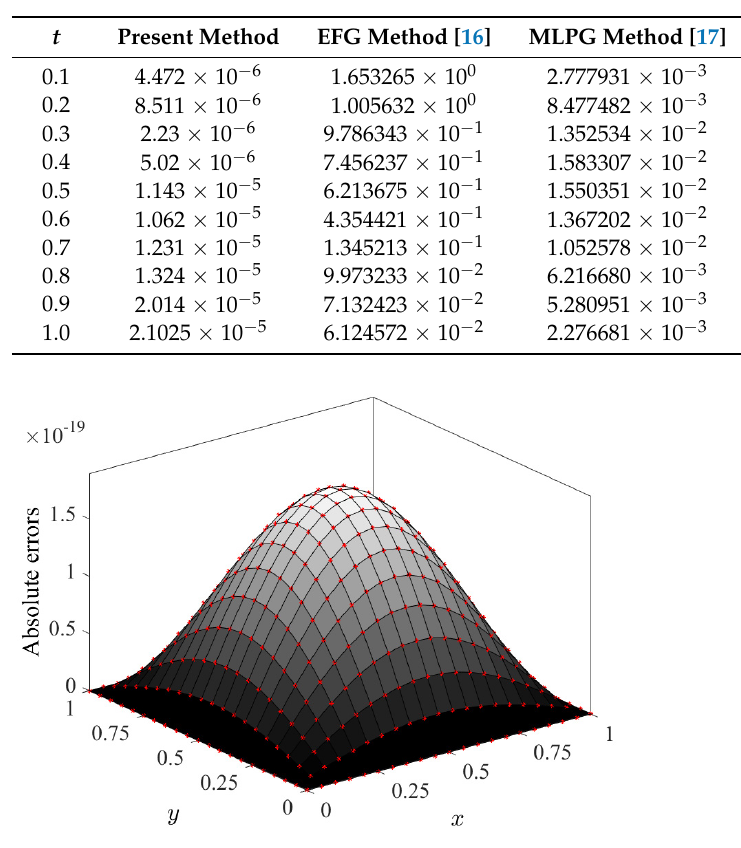
Figure 4. The absolute error norms with h = 0.05 and ∆ t = 0.01 for z = 1 at t = 1.